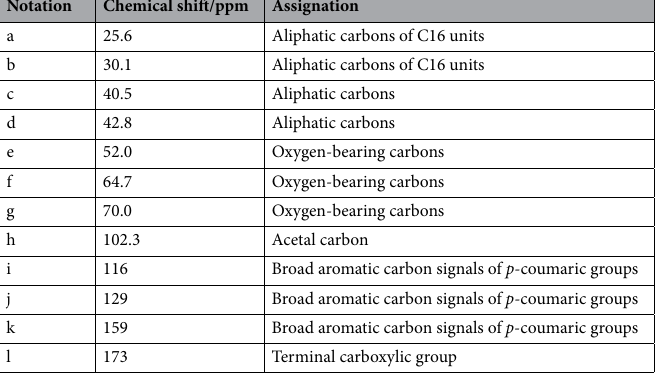
Table 6. Assignation of 13 C CP-MAS NMR spectra of sunflower (A) and rape (B) sporopollenins P2-purified by the enzyme